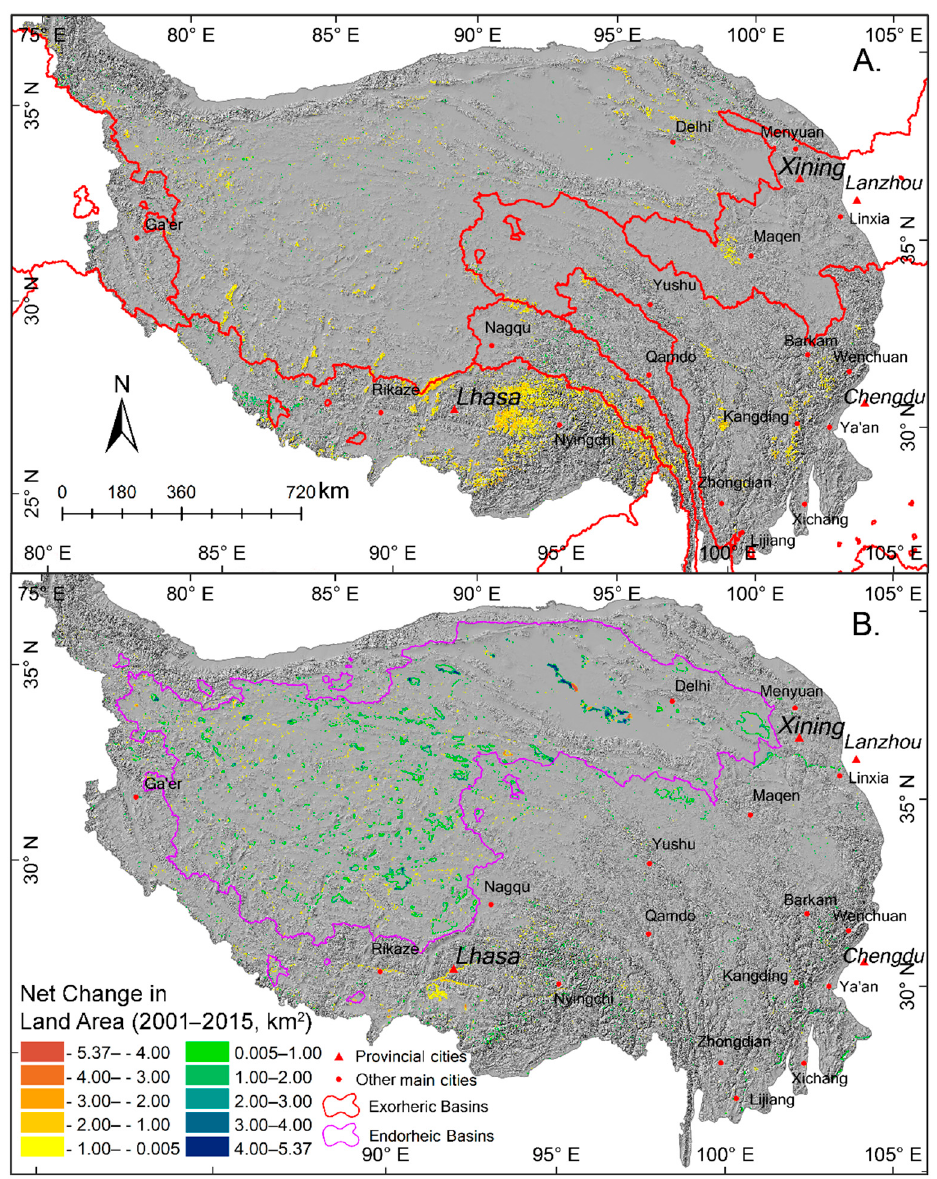
Figure 5. Spatial patterns of net changes in ( A ) permanent snow and ice and ( B ) surface water bodies. Land changes are significant with a p -value < 0.1.